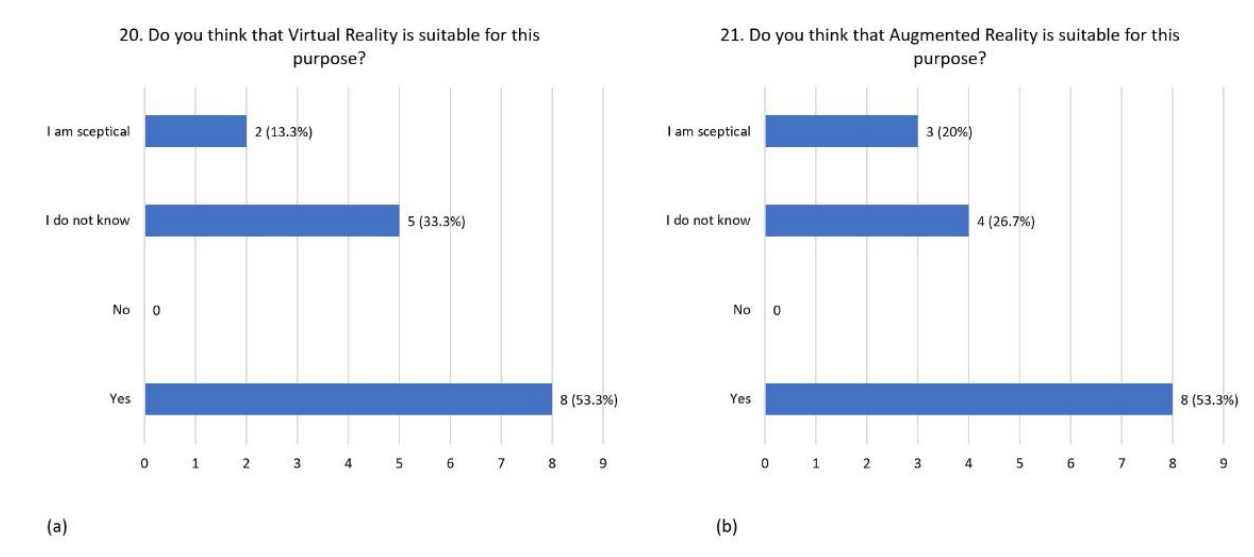
Figure 8. Distribution of responses to question 20 ( a ) and question 21 ( b ).